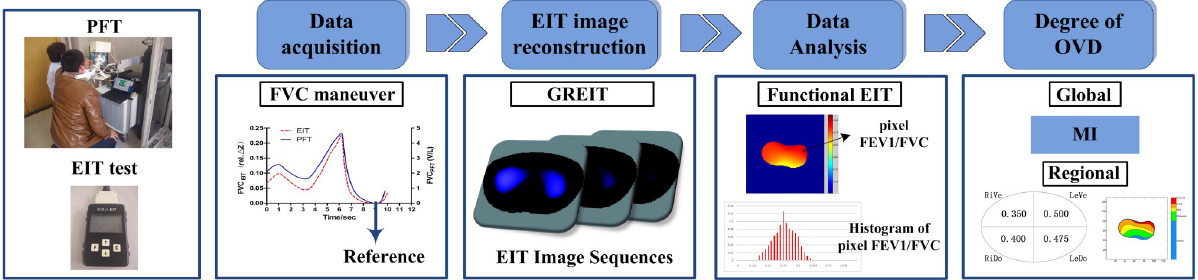
Fig 1. Sequence of processes involved in EIT examination and data analysis. The patient has given written informed consent, as outlined in the PLOS consent form, to publication of his photography.